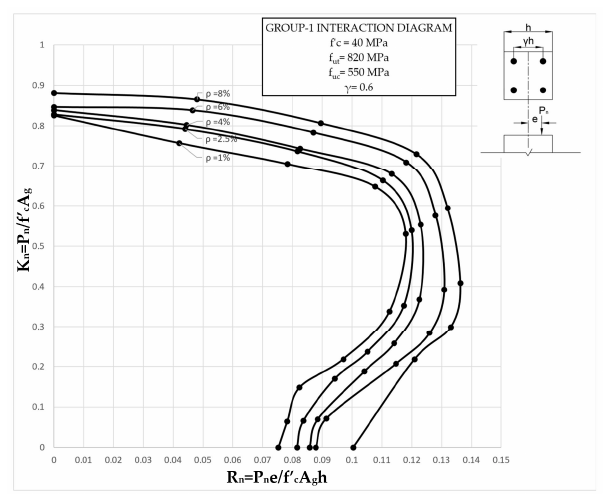
Figure 13. Group 1 interaction diagram.